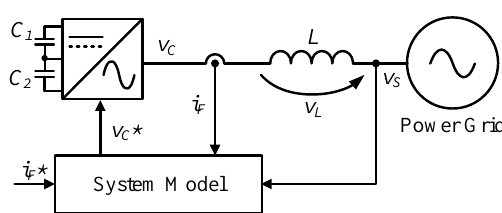
Figure 3. Block diagram of the predictive current control strategy implemented in the 5-level converter SAPF.